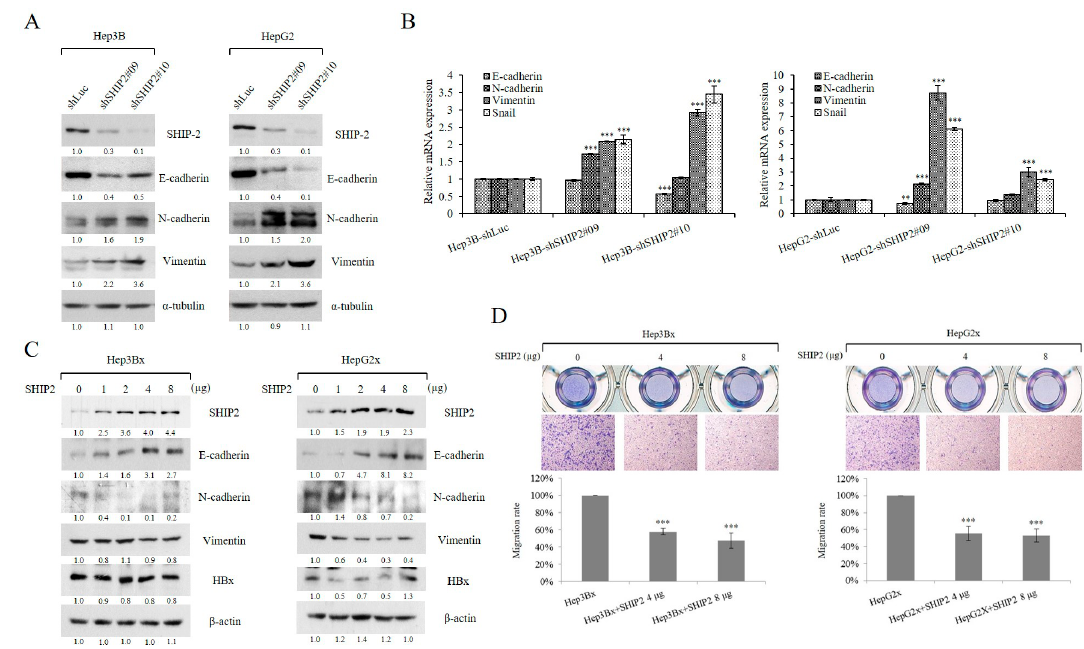
Figure 5. SHIP2 regulates cell motility through the epithelial–mesenchymal transition (EMT) in HCC cell lines. ( A ) An epithelial marker (E-cadherin), mesenchymal markers (N-cadherin and vimentin), and SHIP2 were detected by western blotting in control and SHIP2-knockdown HCC cell lines. ( B ) The mRNA expression of EMT markers was examined by real-time PCR in control and SHIP2-knockdown HCC cell lines. mRNA expression was normalized to actin expression. ( C ) Hep3Bx and HepG2x cells were transiently transfected with SHIP2 plasmid for 48 h. The SHIP2 and EMT markers were examined by western blotting. ( D ) The HBx-expressing HCC cell lines were transfected with SHIP2 plasmid for 48 h. The migration rate was then examined by the Transwell migration assay after a 24 h incubation. Magnification, 100 × . Representative images of migrated cells are shown. Statistical analysis was performed by Student’s t -test. ** p < 0.01; *** p < 0.001 as compared with the control group